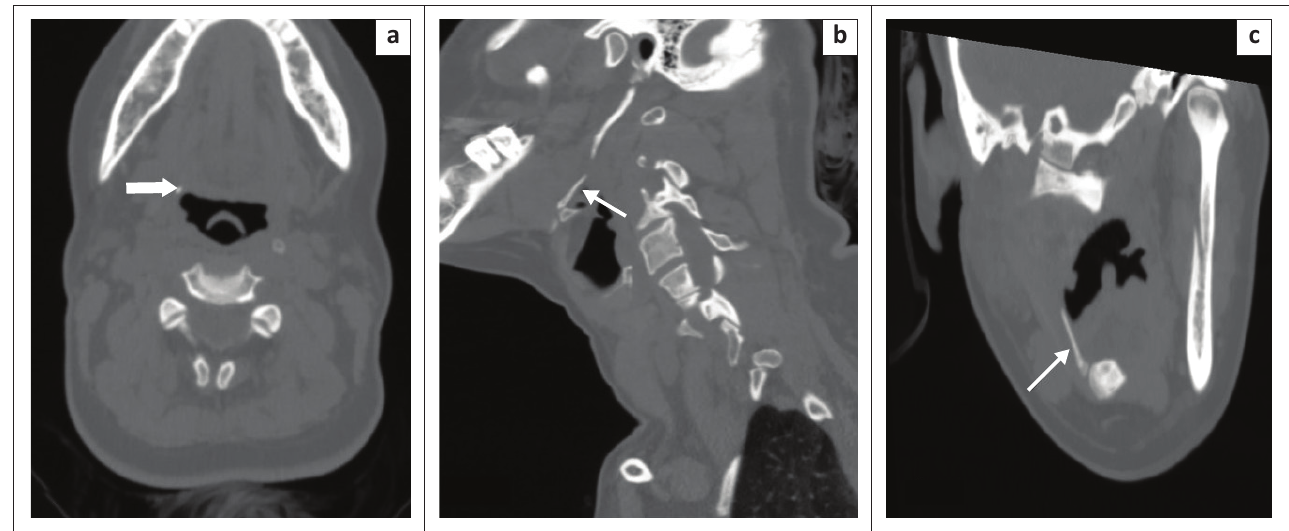
FIGURE 3: (a–c) Computed tomography images of a 65-year-old woman with a foreign body sensation in the right neck following a meal: (a) Axial image shows suspicious hyperdense material near the base of the tongue (arrow) on the right side, mimicking a foreign body. However, (b) sagittal reformatted and (c) 3D multiplanar reformation (MPR) images confirmed it to be the greater cornu or horn of the hyoid